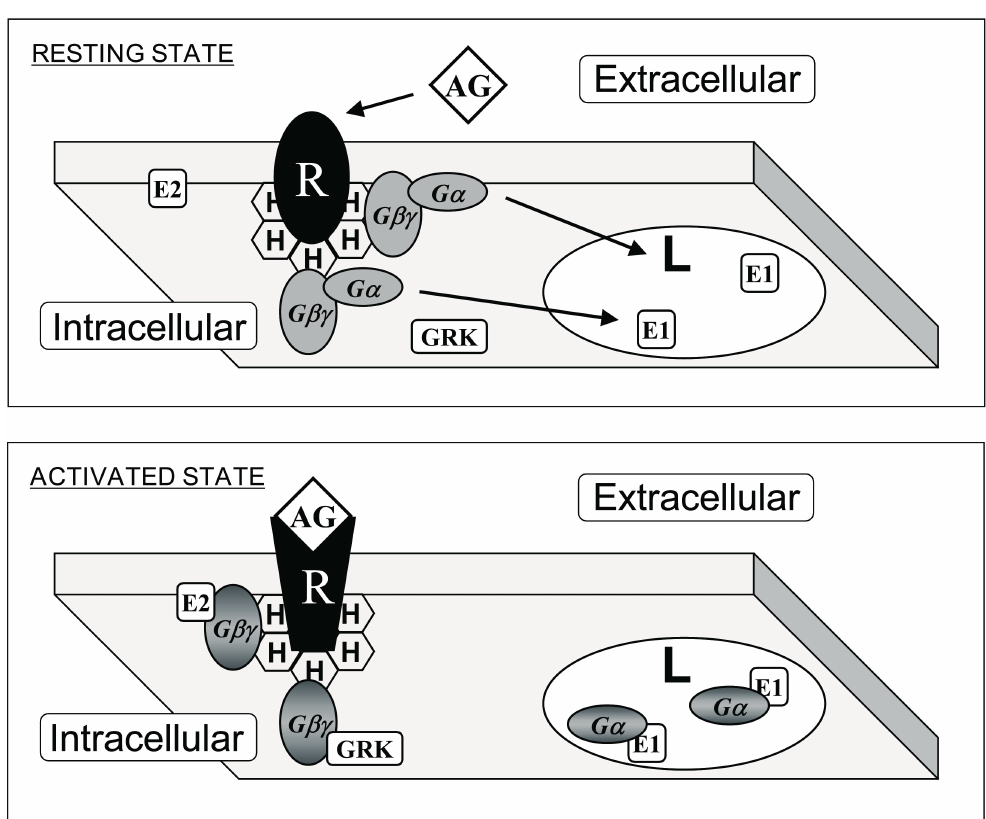
Figure 3. Interaction of G proteins with membrane microdomains. Upper panel : G protein-coupled receptor (GPCR, R) and heterotrimeric G (G αβγ ) proteins prefer membrane microdomains rich in non-lamellar-prone (H) lipids. This e ff ect is driven by prenylated G αβ dimers. Lower panel : Upon receptor-induced activation, acylated G α subunits are mobilized to lamellar-prone membrane microdomains (L). In addition, localization to phosphatidylserine-rich or -poor domains is controled by a polybasic domain exposed to the membrane, and not by the presence or absence of a palmitoyl moiety (see Figure 1). AG: agonist; E1 and E2: e ff ector protein 1 and 2: GRK: GPCR Receptor Kinase. Adapted from Reference